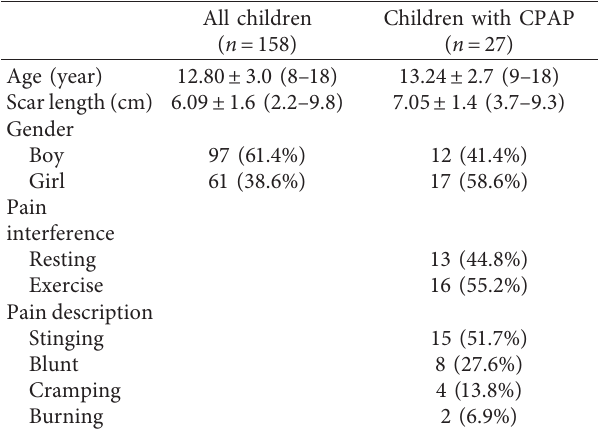
Table 1: Demographic data of children.